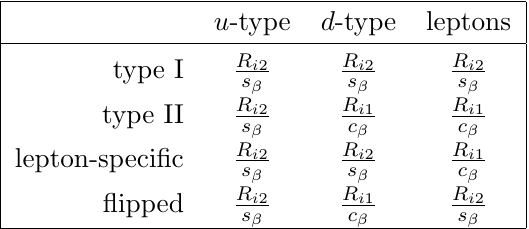
of the Yukawa couplings of the N2HDM Higgs bosons H i as i ff